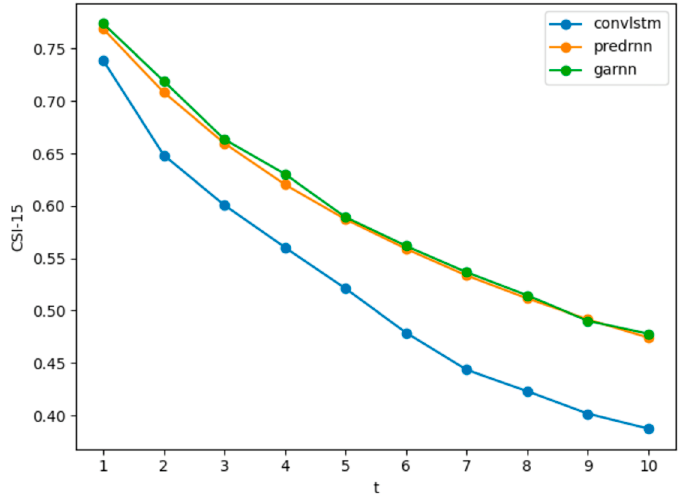
Figure 13. Frame-wise comparison of GARNN, ConvLSTM, and PredRNN at 15 dBZ threshold.